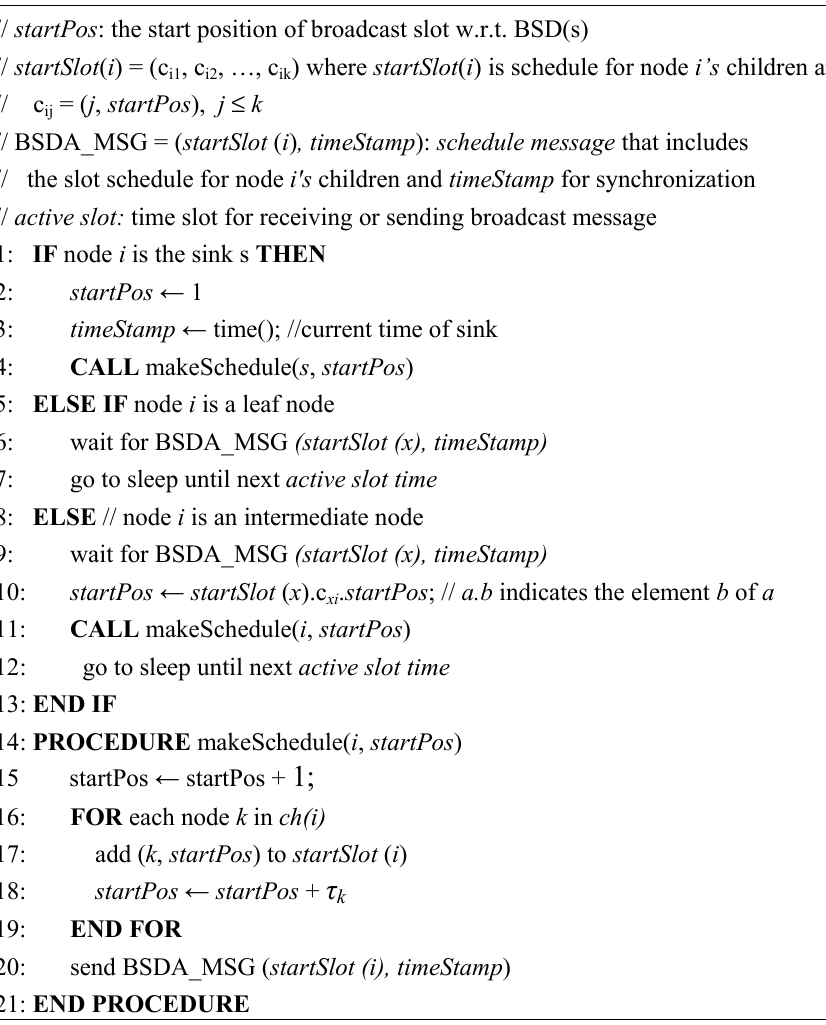
Figure 4. BSD assignment algorithm.